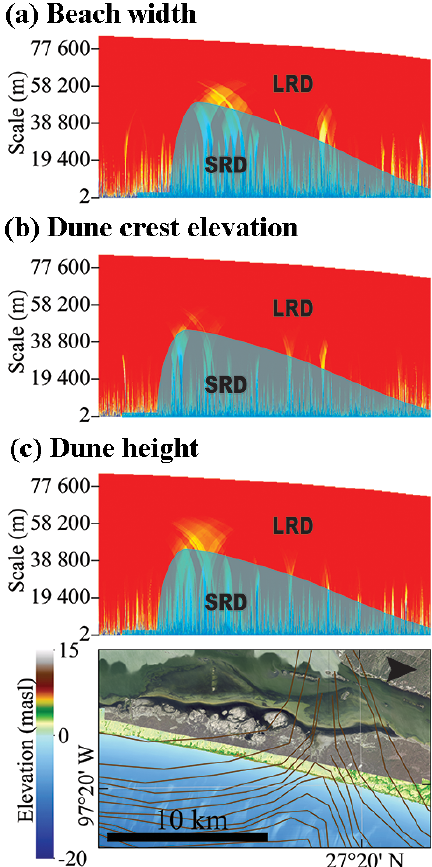
Figure 6. LRD plots of (a) beach width, (b) dune crest elevation, and (c) dune height for PAIS adjacent to the ancestral LOSP Creeks, forming the modern Baffin Bay. LRD breaks down in favor of SRD at the largest scales at the southern edge of the previously identi- fied paleo-channel. The scale at which LRD breaks down to SRD decreases gradually to the north of the channel, suggesting that the paleo-channel asymmetrically influenced beach and dune morphol-